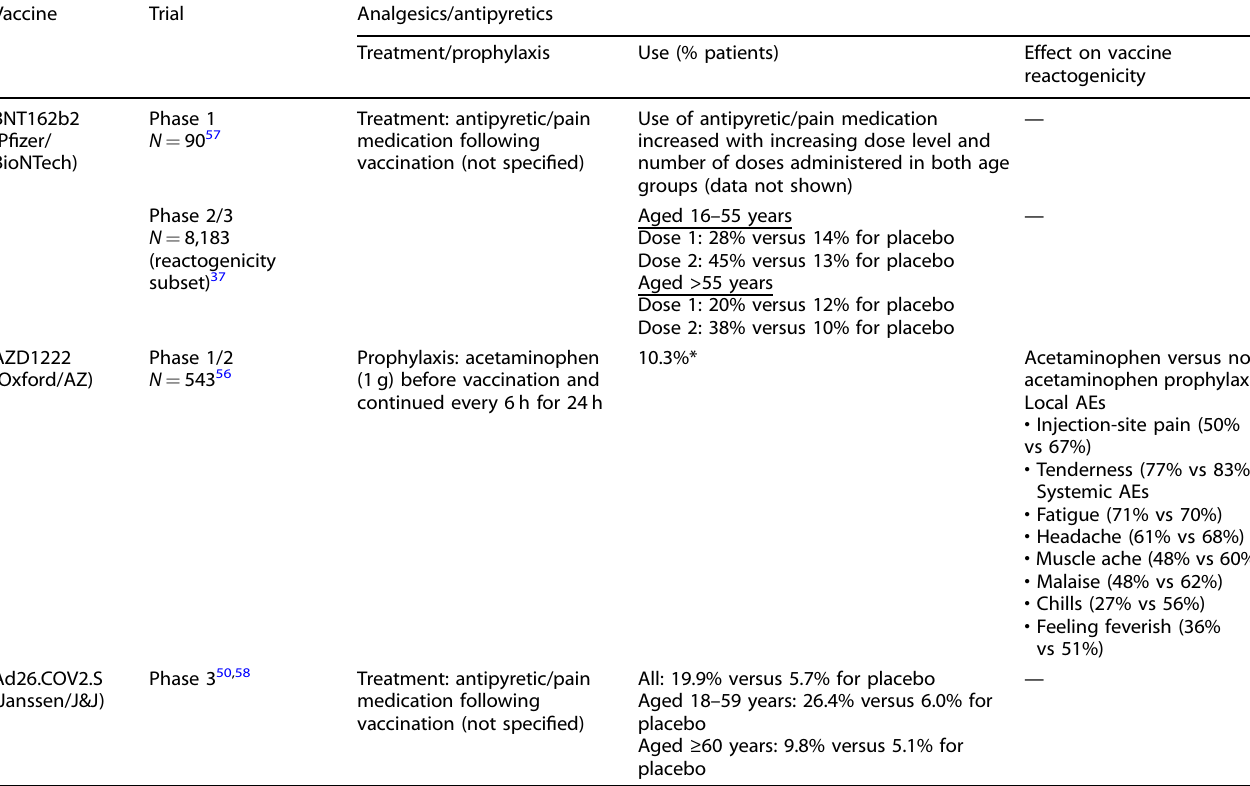
Table 3. Use of analgesic/antipyretic medication on symptoms following COVID-19 vaccination in clinical trials. Vaccine Trial